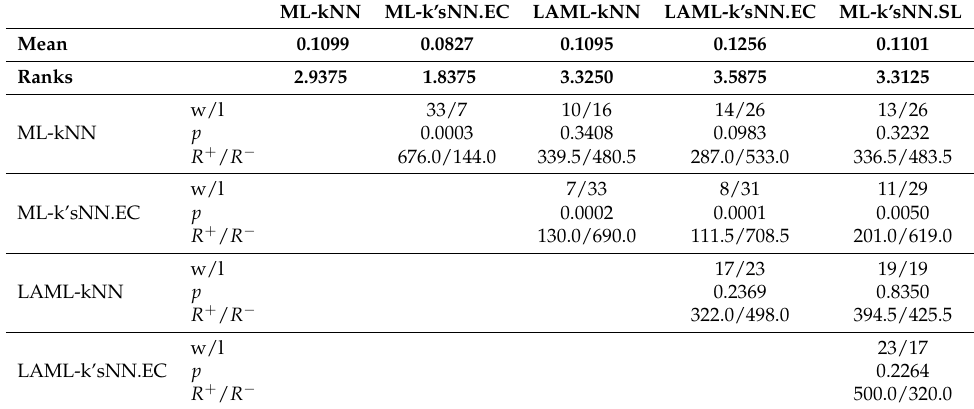
Table 8. Comparison of the different methods using ranking loss